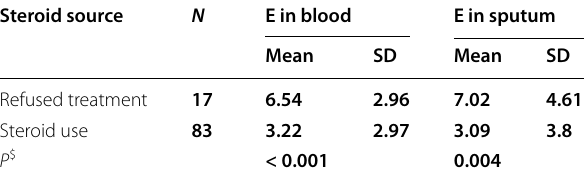
$ Independent t test, P considered significant if < 0.05